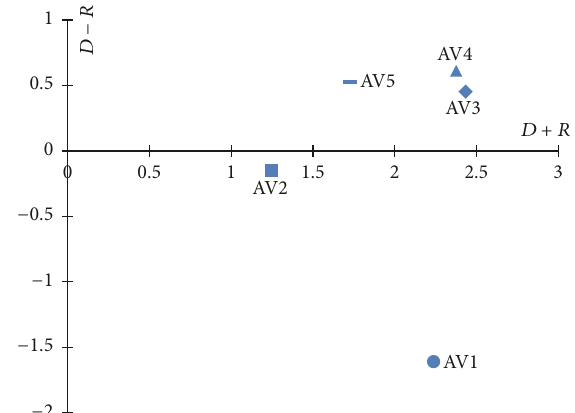
Figure 6: Cause-effect relationship diagram for Availability (Case 2